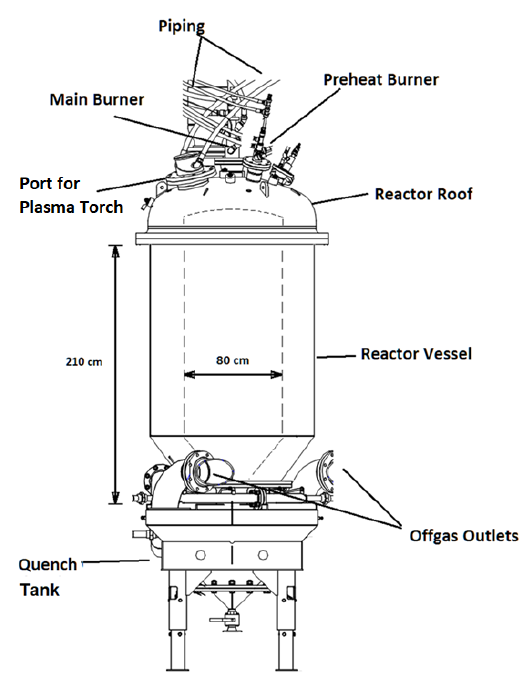
and other details of the facility and its operation are described elsewhere [27].